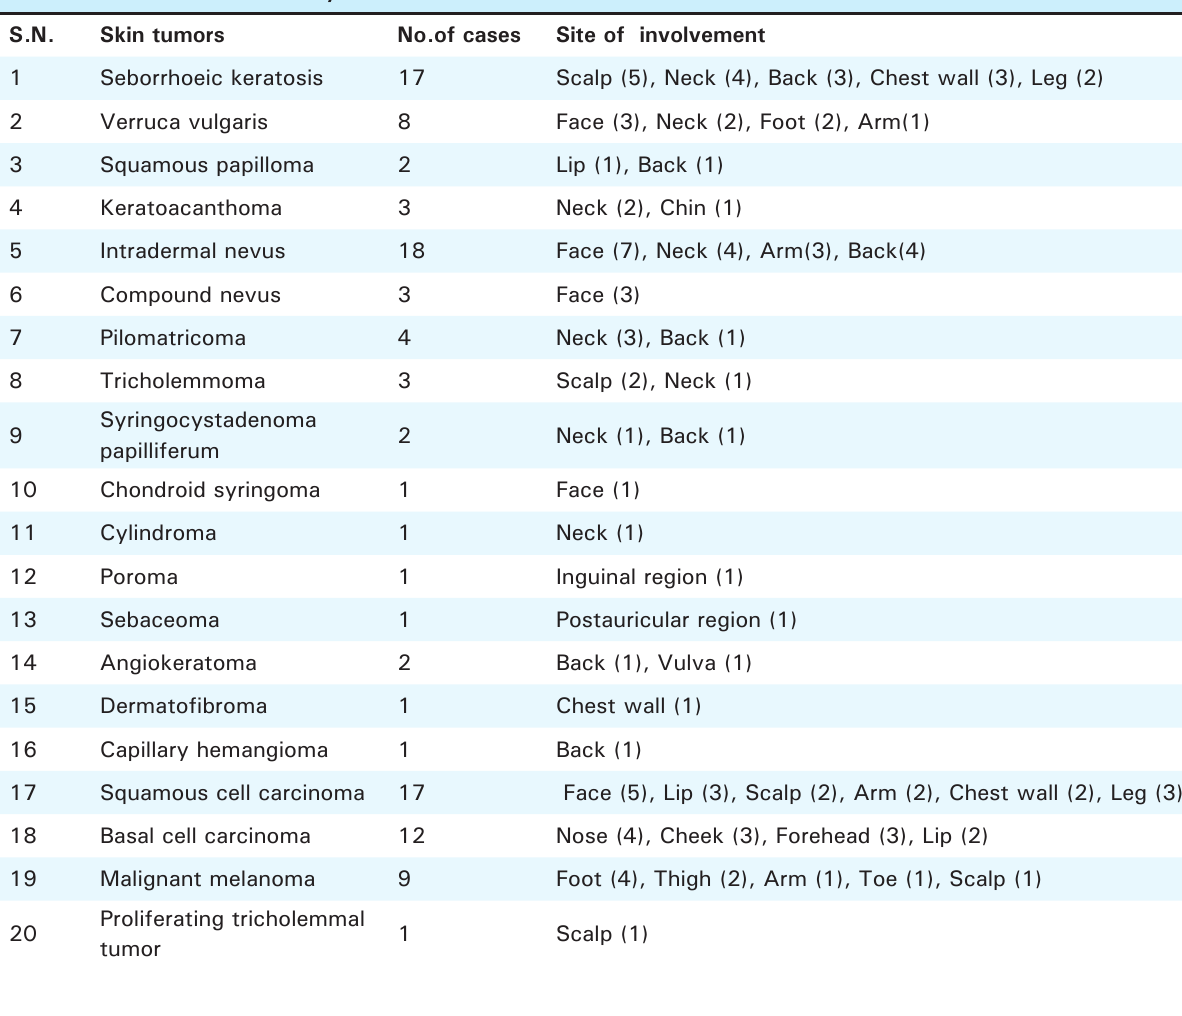
Table 3. Site of involvement by different skin tumors.